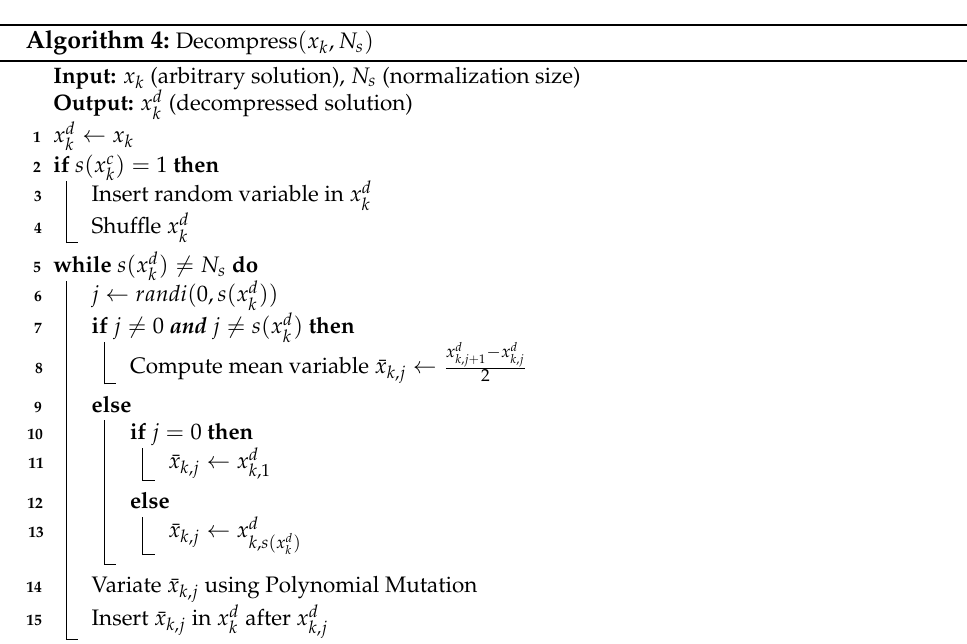
Algorithm 4: Decompress ( x